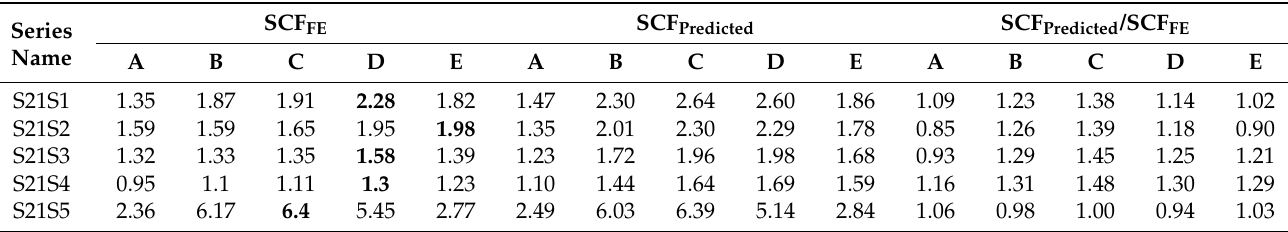
Table 16. SCFs from predicted design equations and FEA at lines